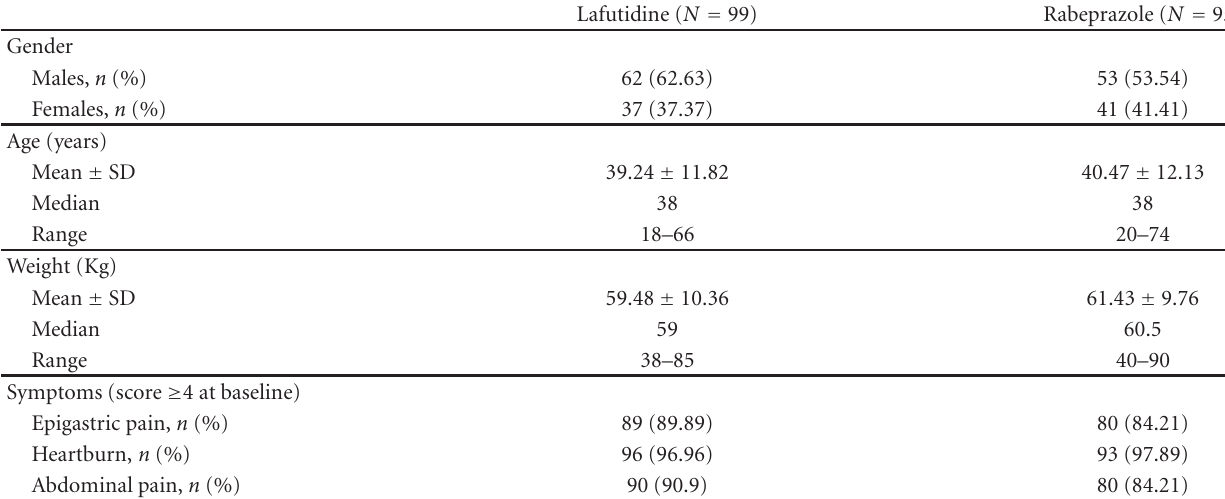
Table 1: Demographic summary.